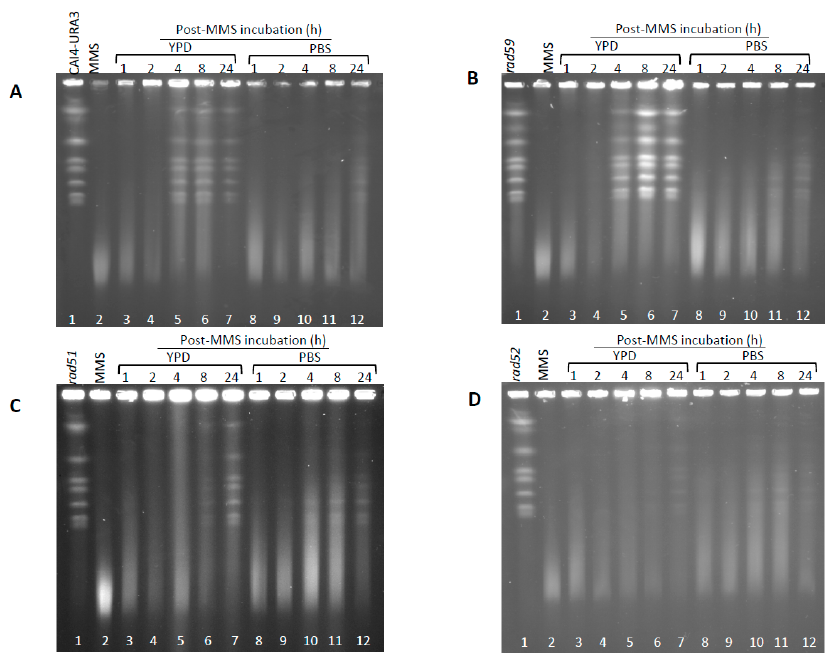
Figure 5. Induction and repair of HDBs by cycling and resting wild type and HR mutants cells of C. albicans . C. albicans wild type (CAI4-URA3) ( A ) and the indicated HR mutants ( rad59 – B -, rad51 – C - and rad52 – D -) were subjected to an acute MMS treatment (0.05% MMS for 30 min). Then cells were treated with 5% sodium thiosulphate, by mixing 1:1 ( v / v ) ratio with 10% Na 2 S 2 O 3 , washed with PBS, and resuspended in MMS-free YPD (cycling cells) or PBS (resting cells) at 30 ◦ C. Samples were taken at the indicated times to calculate OD 600 , CFU (see Figure 7), and to determine PFGE profiles. For PFGE profiles, DNA plugs were incubated with proteinase K at 55 ◦ C.